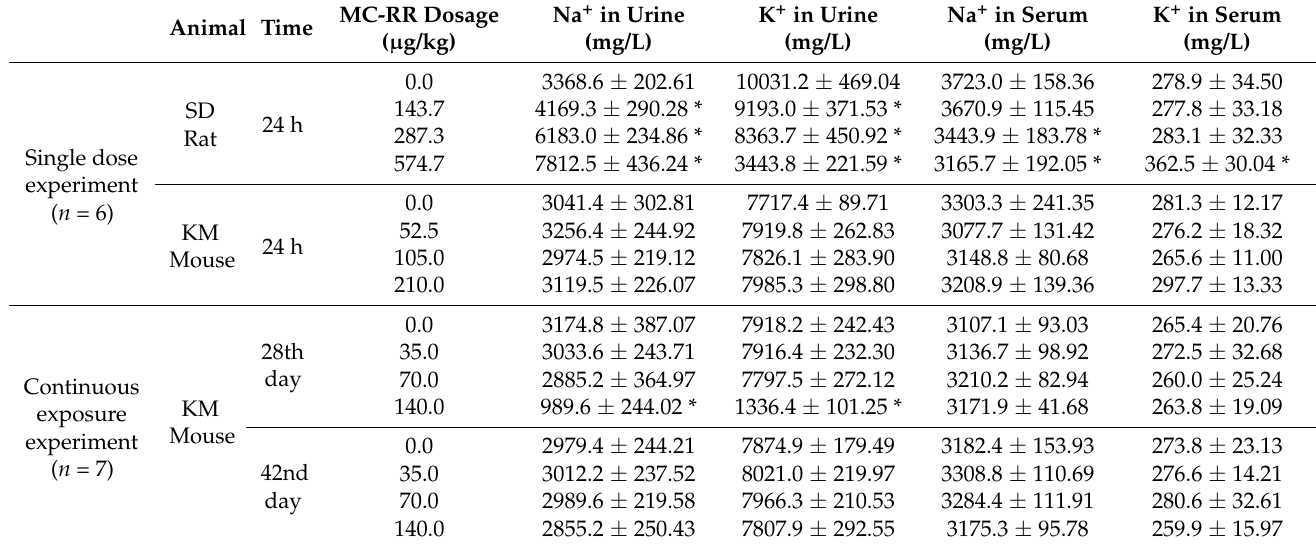
Table 3. Concentration of Na+ and K+ in urine and serum for SD rat and KM mouse (mean ± SD). Animal Time